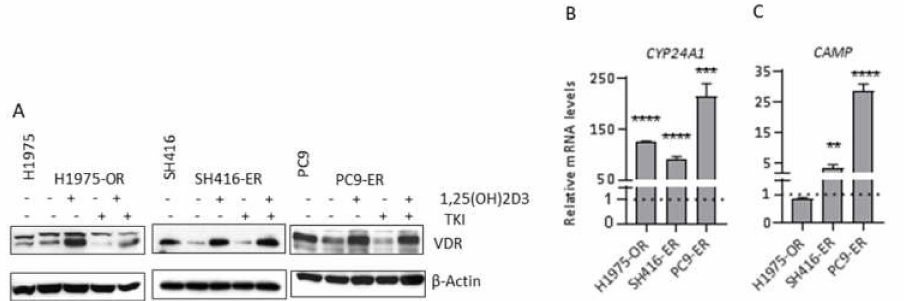
Figure 3. EGFR TKI resistant cells maintain 1,25(OH)2D3 signaling capacity. ( A ) EGFR TKI resistant cells were treated with vehicle control, 100 nM 1,25(OH)2D3, 1 µ M erlotinib (SH416–ER and PC9–ER), 0.5 µ M osimertinib (H1975–OR), or combination of 1,25(OH)2D3 and the corresponding EGFR TKI for 24 h. ( B , C ) EGFR TKI-resistant cells were treated with 100 nM 1,25(OH)2D3 for a total of 96 h